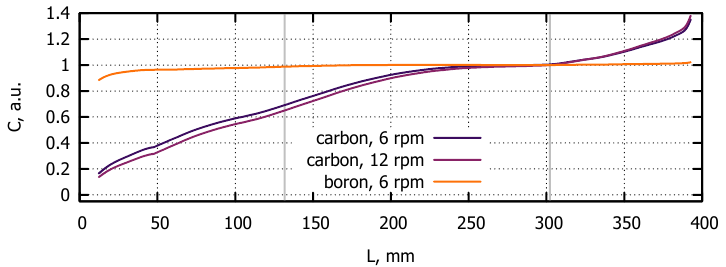
Figure 19. An example of the carbon and boron distribution in the grown crystal ( top ) and the axial distribution of radially averaged concentration of these species ( bottom